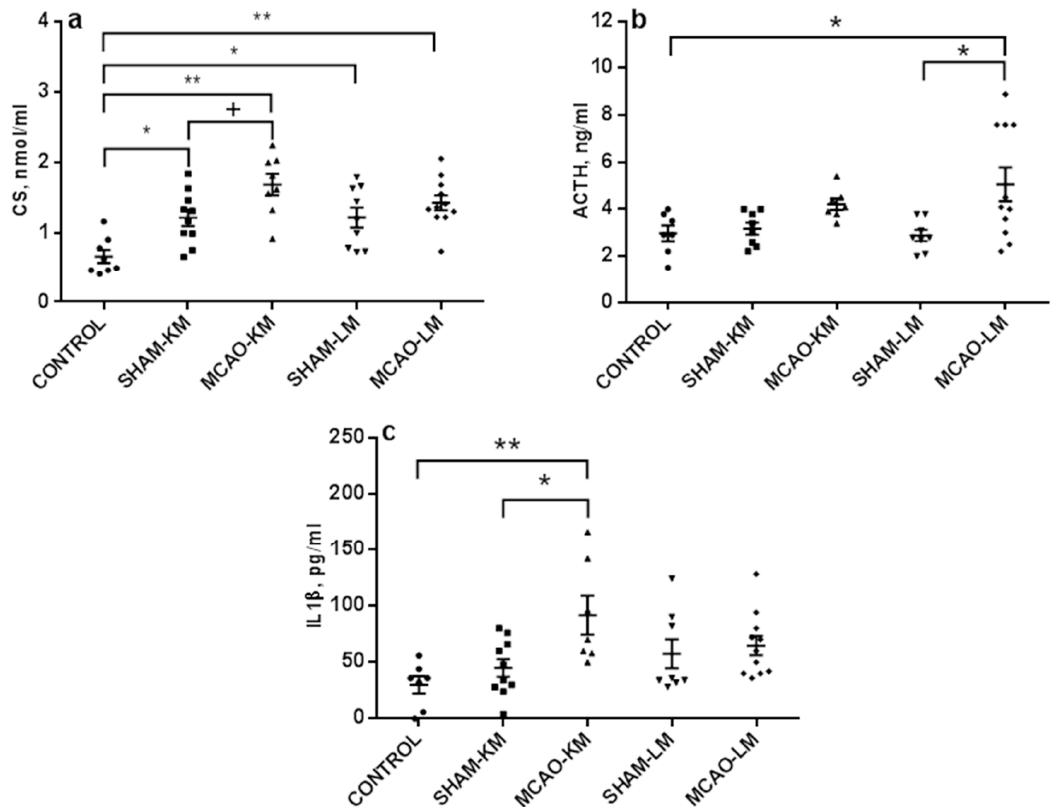
Figure 2. Blood levels of corticosterone ( a ), ACTH ( b ), and IL1 β ( c ) in the MCAO-KM and MCAO-LM groups 3 days after surgery. ( a ) Corticosterone, nmol/mL. ( b ) ACTH, ng/mL. ( c ) IL1 β , pg/mL. ** p < 0.01, * p < 0.05, and + p < 0.1 compared to the respective sham-operated groups or control rats.